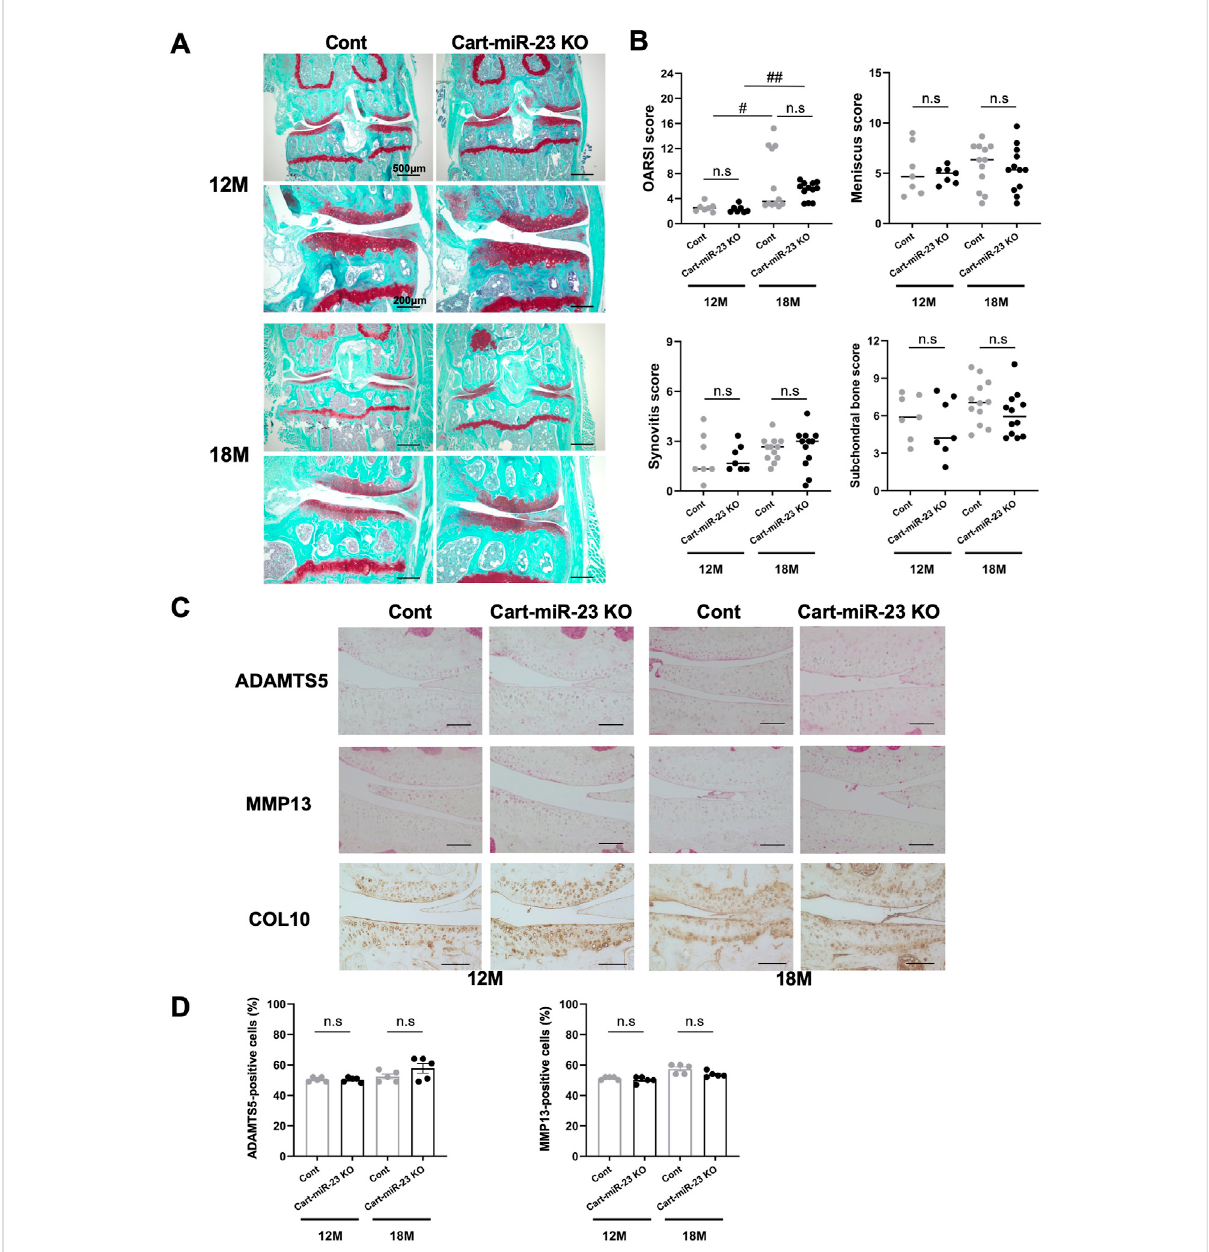
FIGURE 3 Histopathological evaluation of Knee joint tissues in Cart-miR-23clus KO mice with aging. (A) Safranin O staining of the knee joints of Control andCart-miR-23clusKOmiceat12and18 monthsofage.Scalebars:500 µmand200 µm. (B) TherightkneejointsofControlandCart-miR-23clus KO mice at 12 months of age (Control: n = 7, Cart-miR-23clus KO: n = 7) and 18 months of age (Control: n = 12, Cart-miR-23clus KO: n = 12) were assessed by OARSIscoring, meniscus scoring, synovitis scoringand ScBscoring system. The data wasrepresented as median. Scoring data was analyzed by Kruskal – Wallis test, the Dunn ’ s multiple comparison test was applied; # p < .05, ## p < .01. (C,D) Knee joints from Control and Cart-miR- 23clus KO mice were assessed by immunohistochemistry using anti-ADAMTS5, anti-MMP13, and anti-Type X Collagen antibodies ( n = 5 per group). Scale bars: 100 µm. The data represented as mean ± SEM. Comparison of mean values was performed using Welch ’ s t -test with Holm-Sidak correction for multiple comparison. n. s: non-signi fi cant difference.